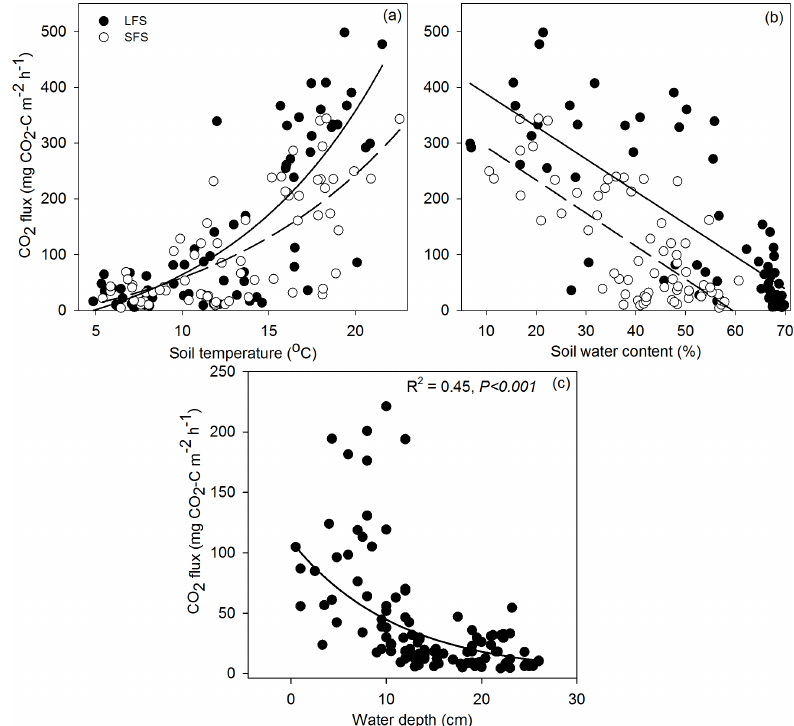
Figure 5. Relationships between CO 2 fluxes and (a) soil temperature, (b) soil moisture and (c) water depth at the LFS. The lines in (a) represent the best-fit regression y = 50 . 69 ( exp0 . 09 · T ) , R 2 = 0 . 56, P < 0 . 001 and y = 53 . 62 ( exp0 . 07 · T ) , R 2 = 0 . 44, P < 0 . 001 for the LFS and SFS, respectively. The lines in (b) represent the best-fit regression y = 446 . 26 − 5 . 82 · ( SWC ) , R 2 = 0 . 52, P < 0 . 001 and y = 351 . 95 − 5 . 92 · ( SWC ) , R 2 = 0 . 54, P < 0 . 001 for the LFS and SFS, respectively. The relationship in (c) is represented by y = 109 . 65 ( exp ( − 0 . 04 · WD )) , R 2 = 0 . 45, P < 0 . 001. Values in (a, b) are means for n =